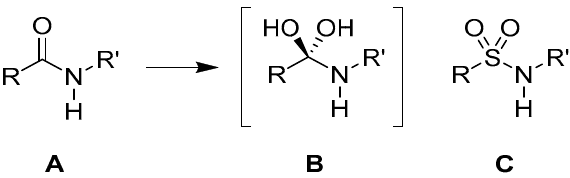
Figure 24. ( A ) Peptide bond structure. ( B ) Transition state for the hydrolysis of the peptide bond. ( C ) Sulfonamide bond as a suggested transition state isostere.